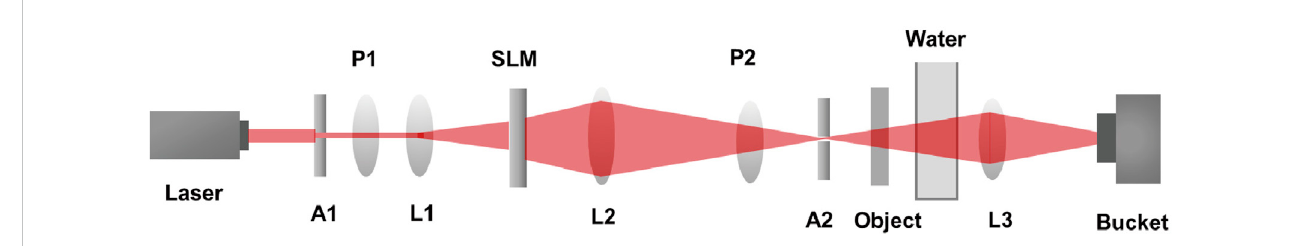
FIGURE 2 Setup of the underwater laser GI based on Walsh speckle patterns.